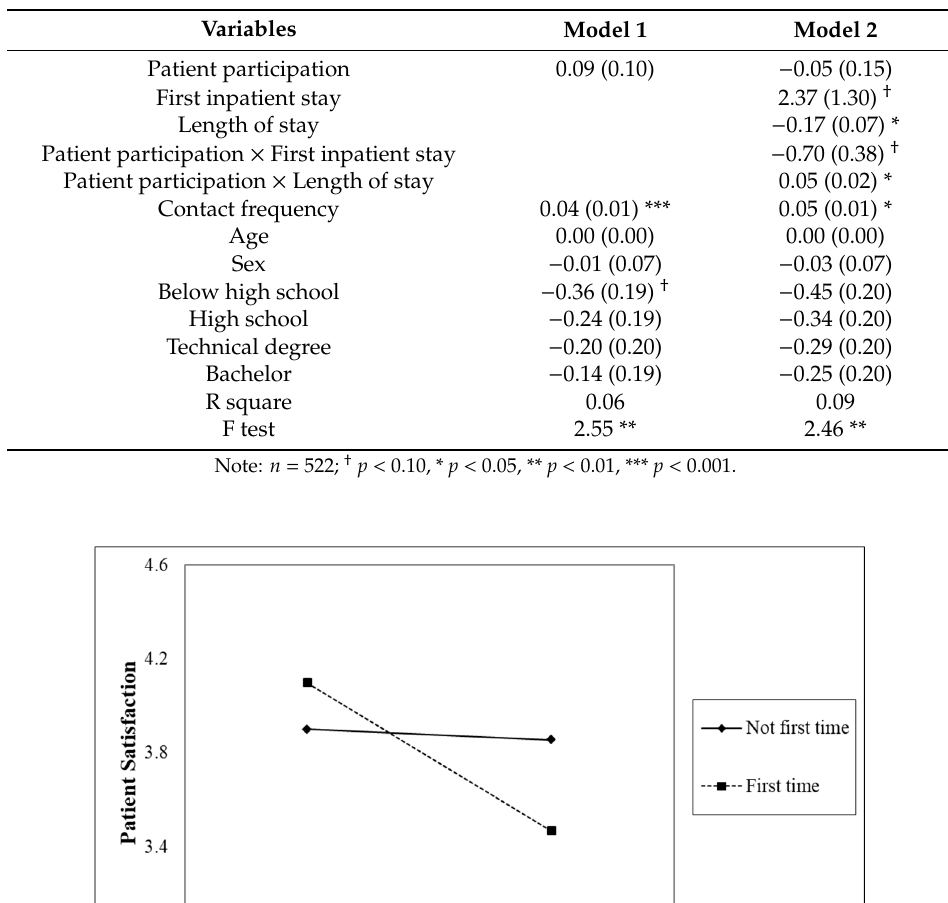
Table 4. E ff ect and boundary conditions of patient participation on patient satisfaction.